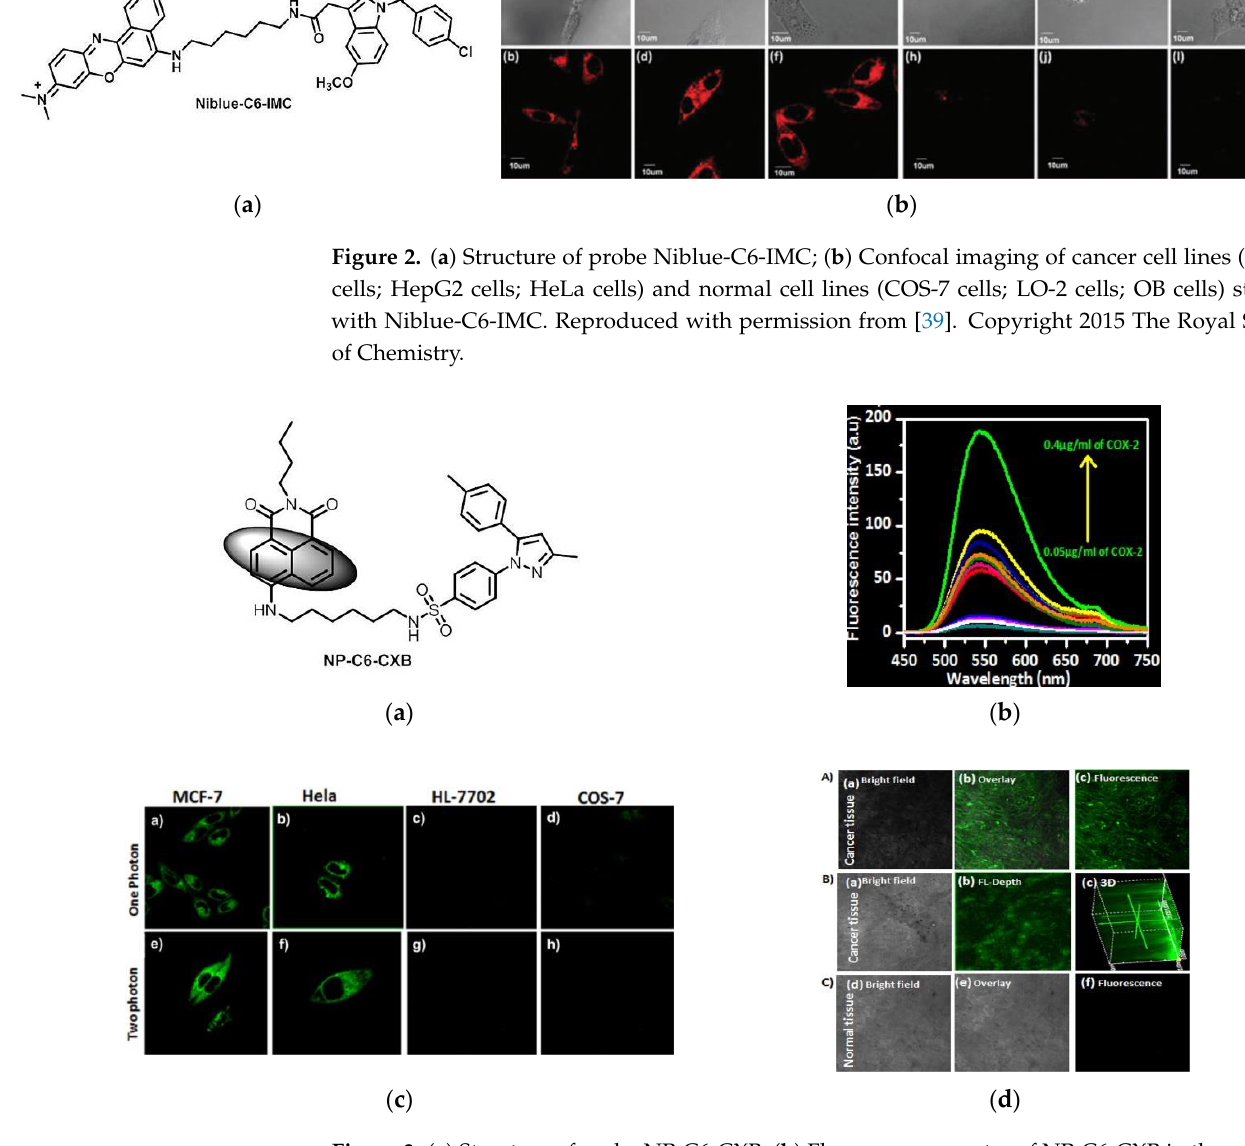
Figure 3. ( a ) Structure of probe NP-C6-CXB; ( b ) Fluorescence spectra of NP-C6-CXB in the pres- ence of COX-2; ( c ) Fluorescent images of live cells under excitation of one-photon and two-photon; ( d ) Fluorescence imaging of cancer and normal tissues. Reproduced with permission from [40].